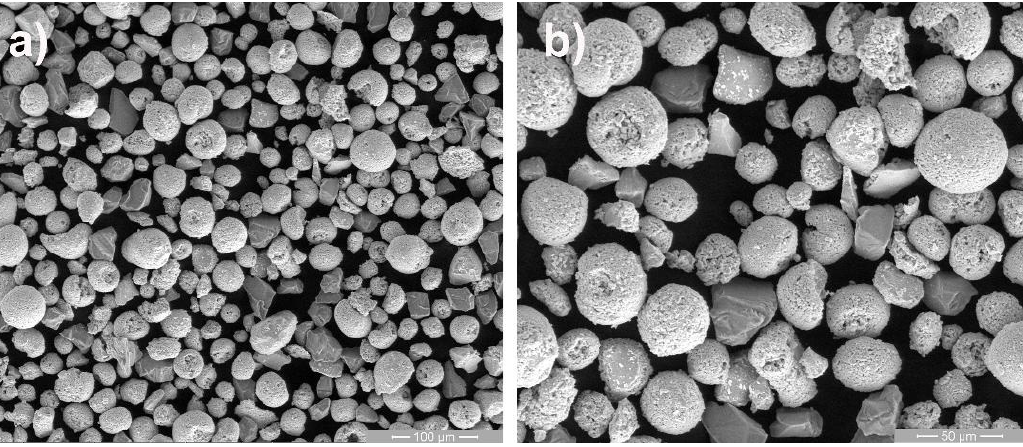
Figure 2. Micrographs of the powder morphology: ( a ) 500x magnification; ( b ) 1000x magnification.